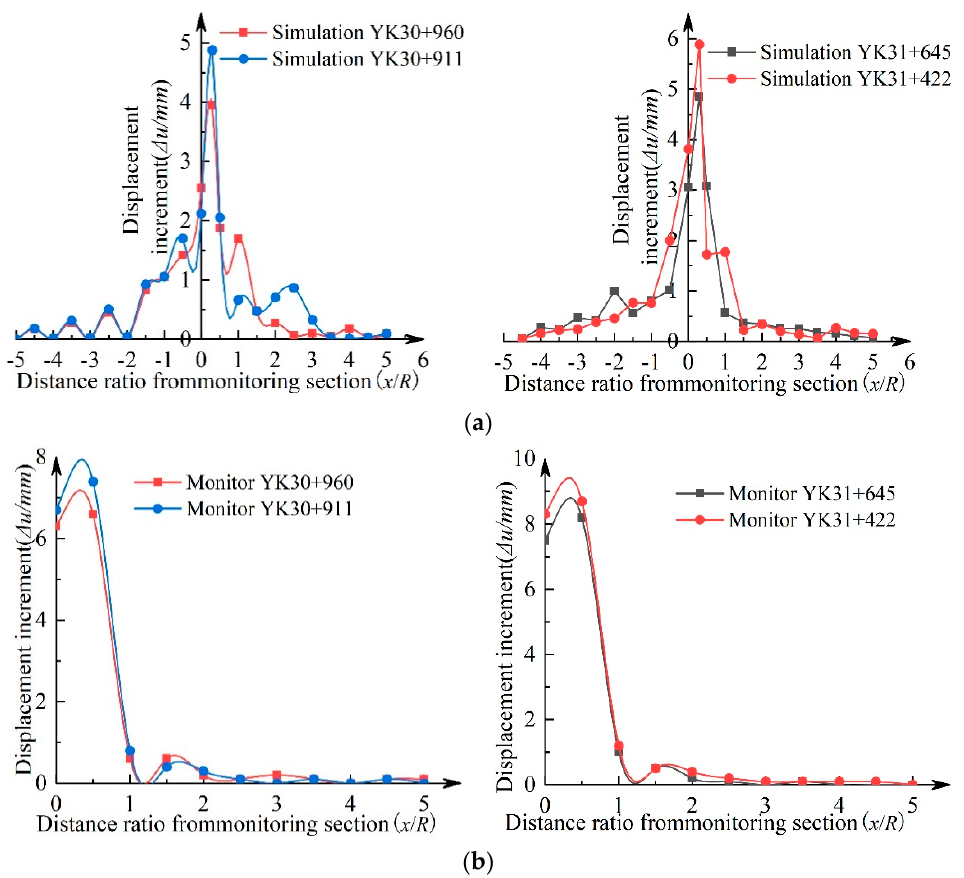
Figure 12. Displacement increment curve of different sections: ( a ) numerical simulation displacement increment change curve; ( b ) field monitoring displacement increment change curve.